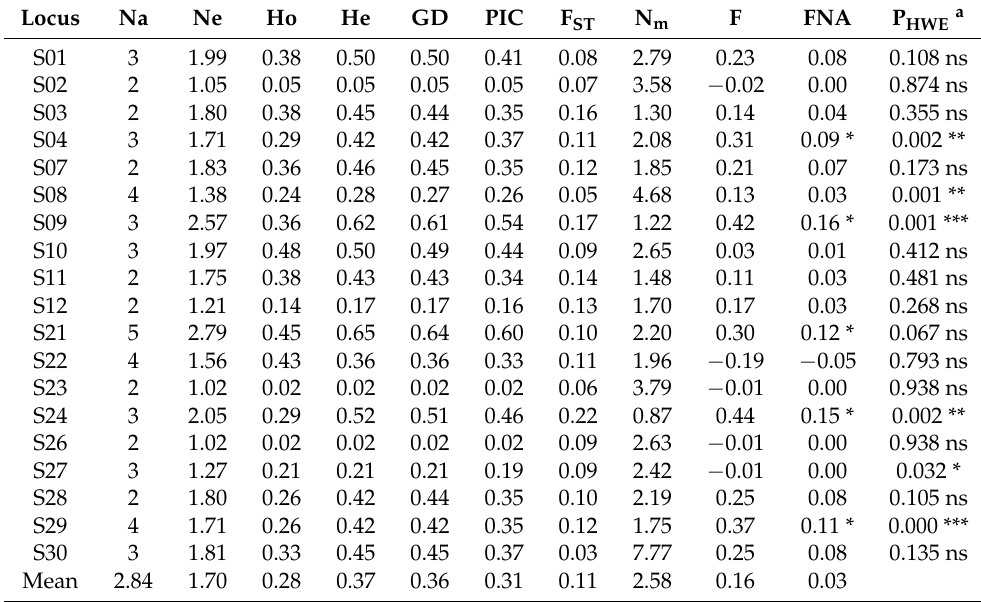
Table 3. Diversity statistics of the 19 SSR loci across 42 D. odorifera